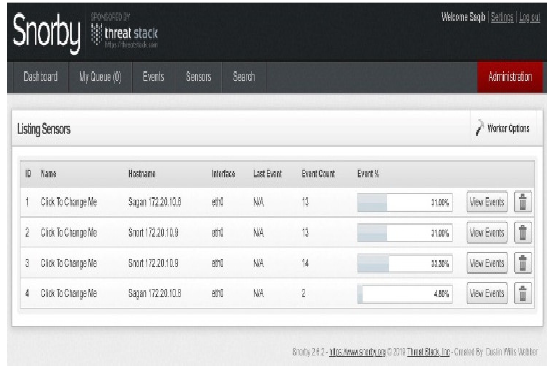
Fig. 25: Sensor used to detect the